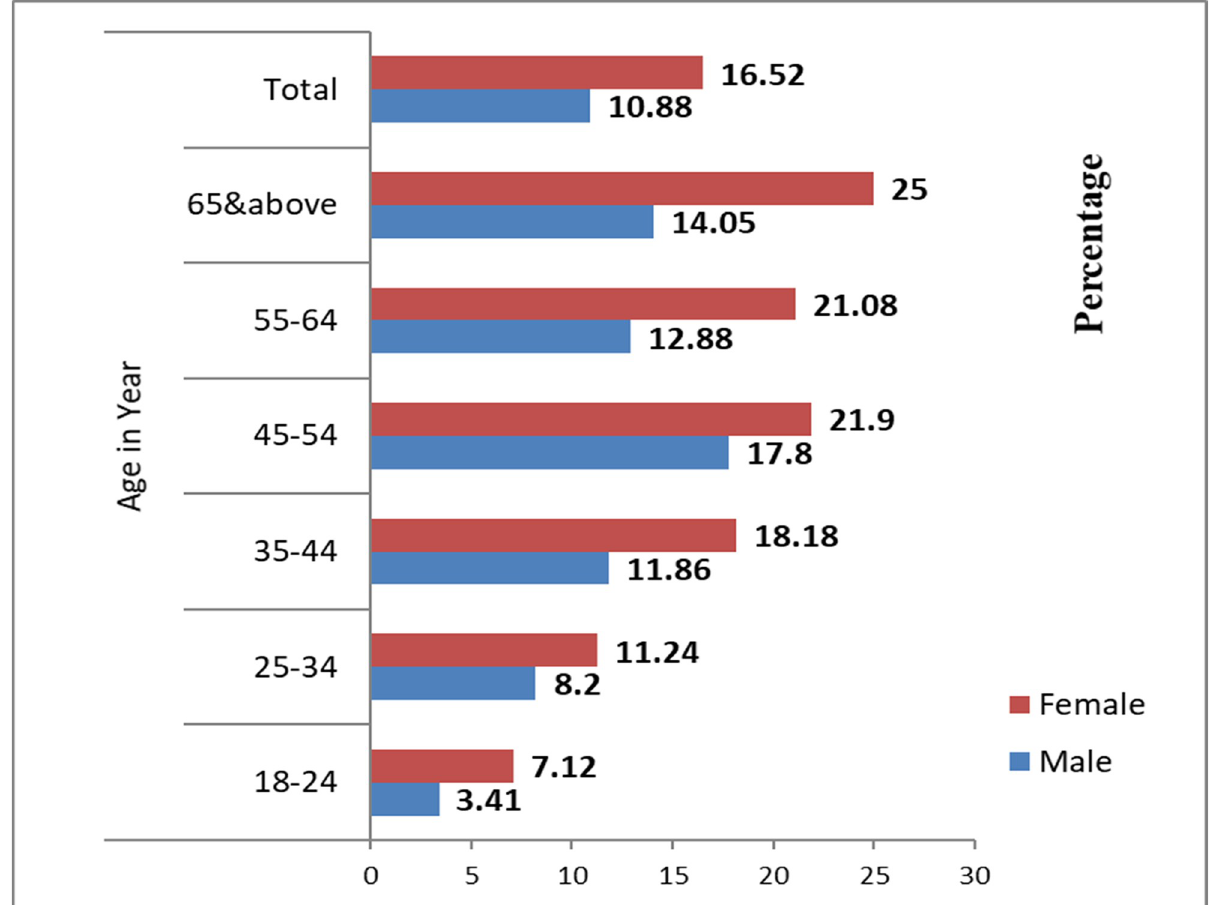
Fig 4. Distribution of high LDL cholesterol level by age and sex among � 18 years old Gondar city residents, Northwest Ethiopia.